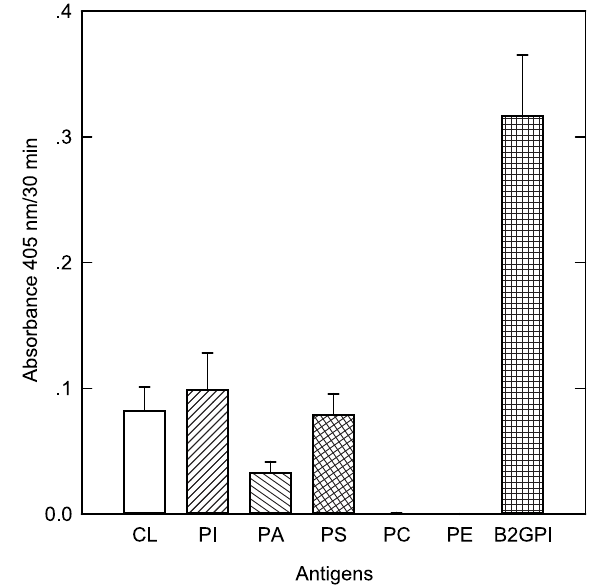
Figure 5. The antigenic specificity of IgG that was bound by an ATP column. Binding of IgG to CL, PI, PA, PS, PC, PE and b 2 - Glycoprotein I ( b 2 GPI) were measured in samples obtained from 8 patients as described in the methods. Results are presented as mean ^ SE.